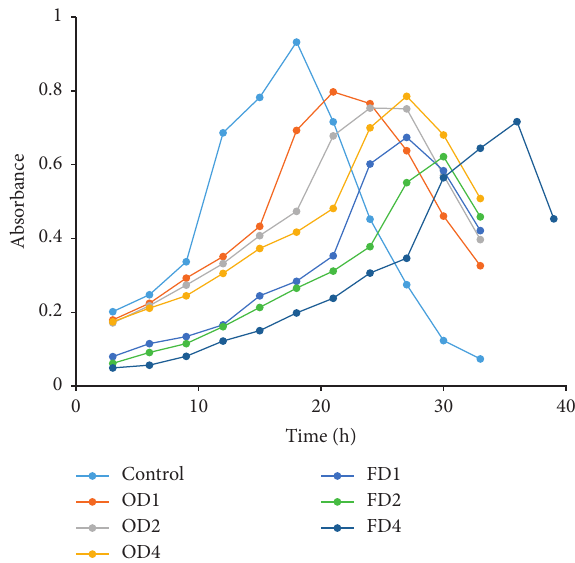
Figure 7: Kinetics of soybean oil peroxidation in OD and FD microcapsules with shell:core ratios of 1, 2, and